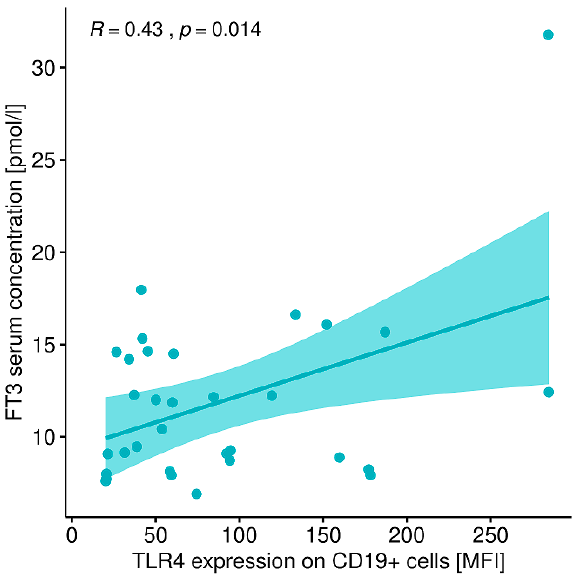
Figure 16. Correlation between the expression level of TLR-4 on CD19 + B lymphocytes (MFI) and the concentration of FT3 (pmol / L) in patients with GD before treatment. MFI, mean fluorescence